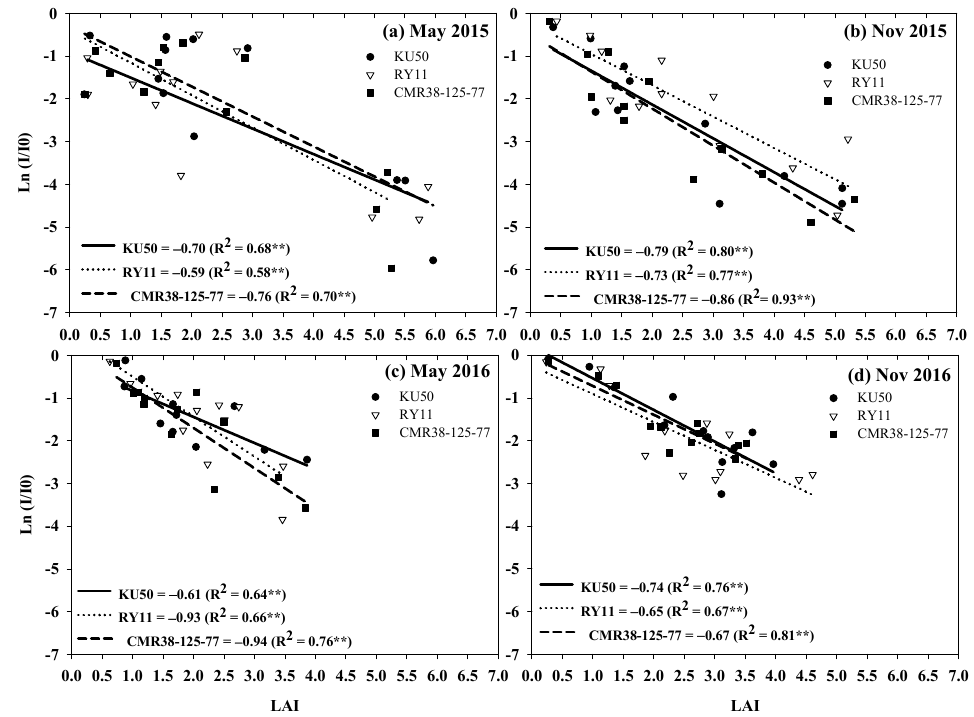
Figure 4. Regression analysis for ln(I/Io) and LAI of 3 cassava genotypes planted in May and No ‐ vember 2015 ( a , b ) and 2016 ( c , d ). ** = significant at p < 0.01 probability levels.